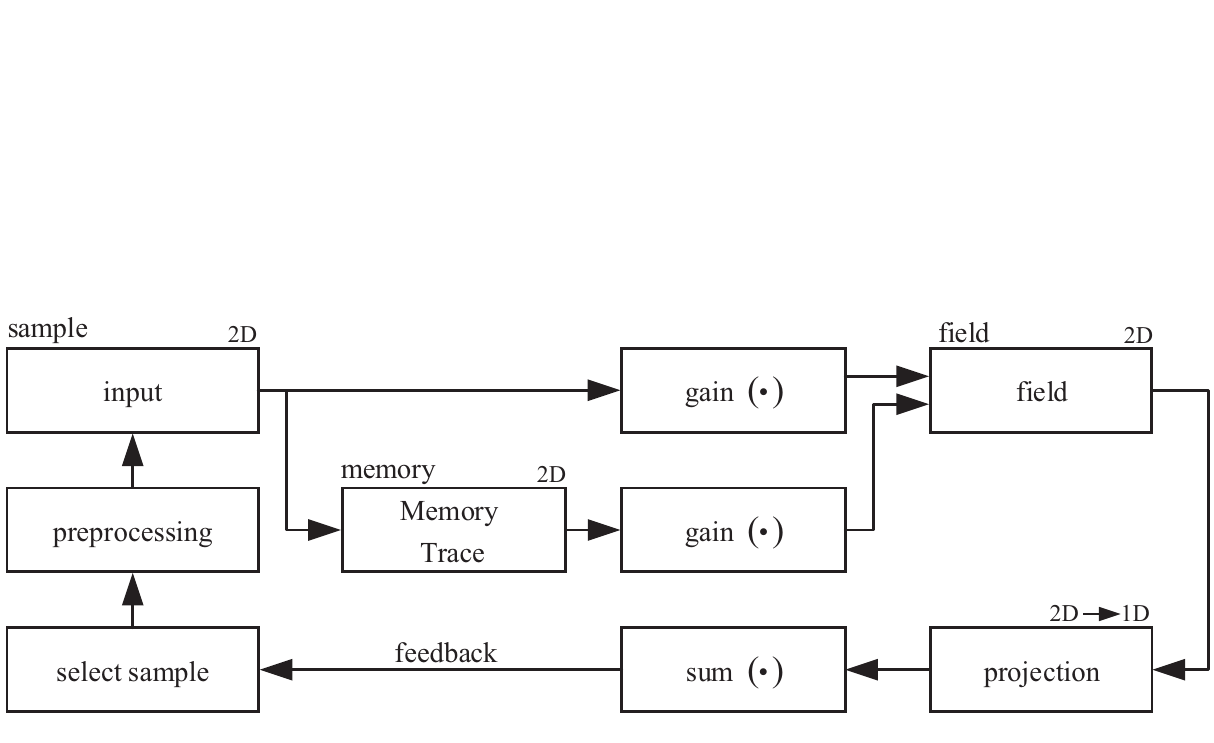
Figure 10. System architecture to generate trajectory-based